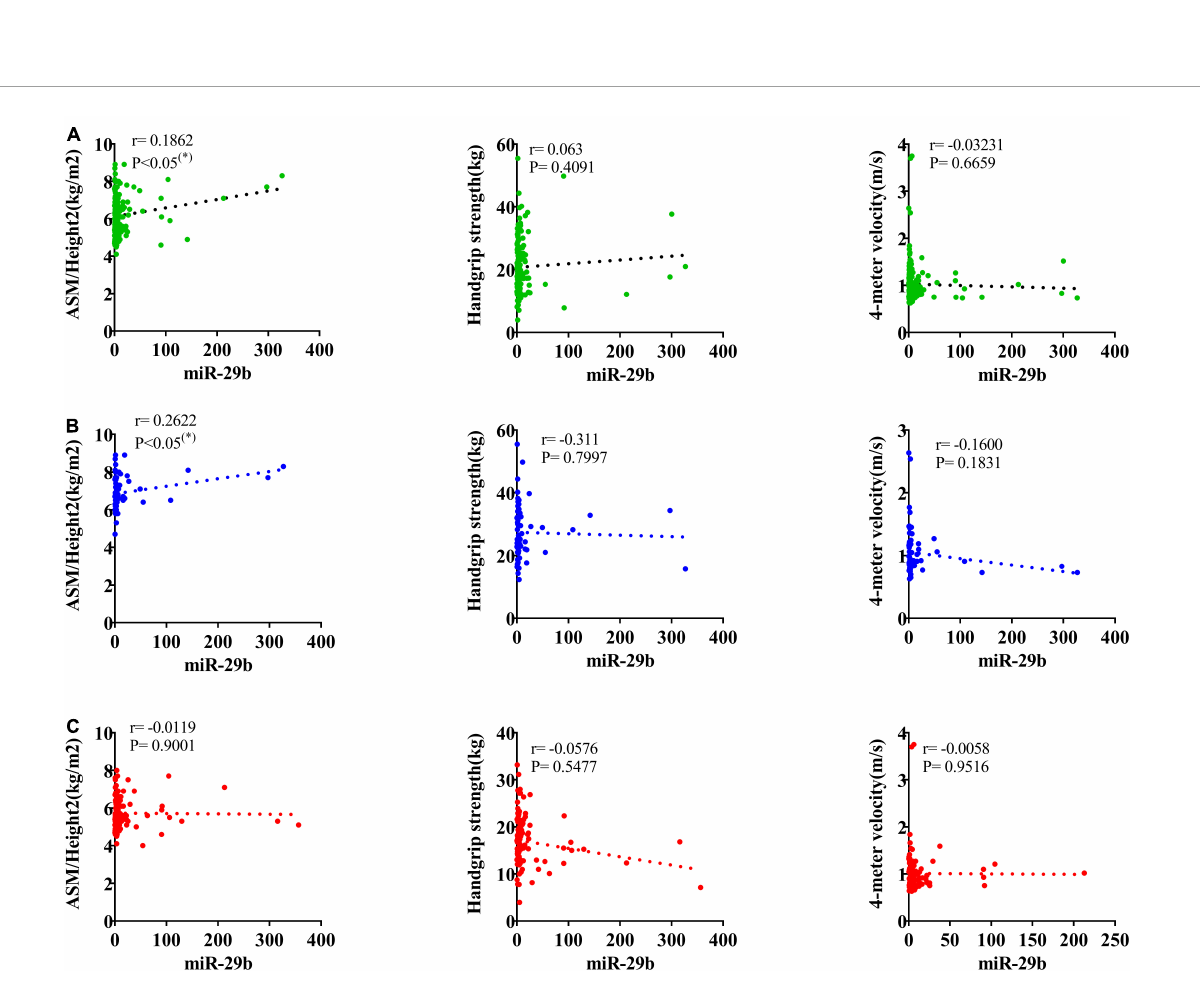
FIGURE4 Correlation analysis between the changes of miR-29b and appendicular skeletal muscle mass (ASM)/Height 2 (kg/m 2 ), handgrip strength (kg), and 4-m velocity (m/s). The correlation between the changes of miR-29b and the diagnostic indicators of sarcopenia (ASM/Height2, handgrip strength, and 4-m velocity) in sarcopenic and non-sarcopenic subjects (A) . Pearson’s method was used for correlation analyses; ∗ P < 0.05; n = 186. The correlation analysis of miR-29b with these indicators in male subjects (B) . Pearson’s method was used for correlation analyses; ∗ P < 0.05; n = 67. The correlation analysis of miR-29b with these indicators in female subjects (C) . Pearson’s method was used for correlation analyses; ∗ P < 0.05; n =